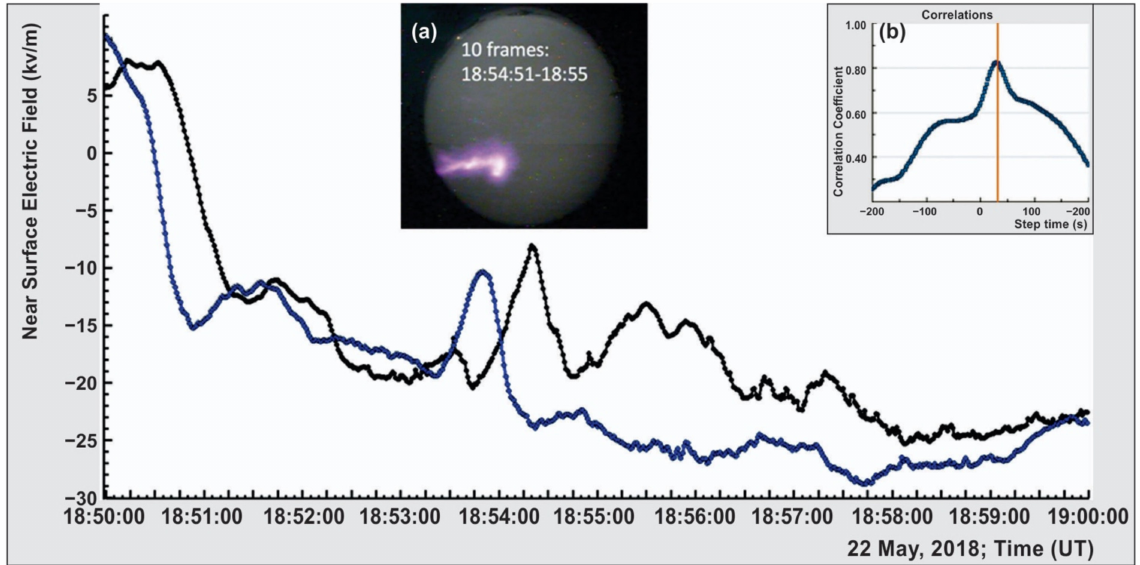
Figure 18. 1s time series of NSEF disturbances measured by sensors located on the roof of MAKET building (black) and located above housing of GAMMA scintillators on 1 m high mast (blue). In the inset ( a )—the typic pattern of the light-glow, ( b )—the delayed correlations